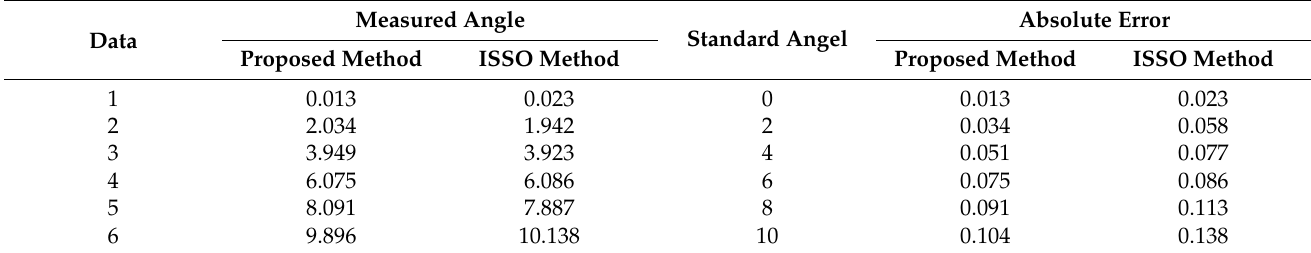
Table 5. Static rotation angle error ( ◦ ).